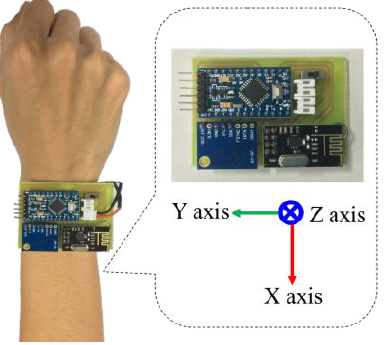
Figure 7. Wearable motion sensing device mounted on wrist.